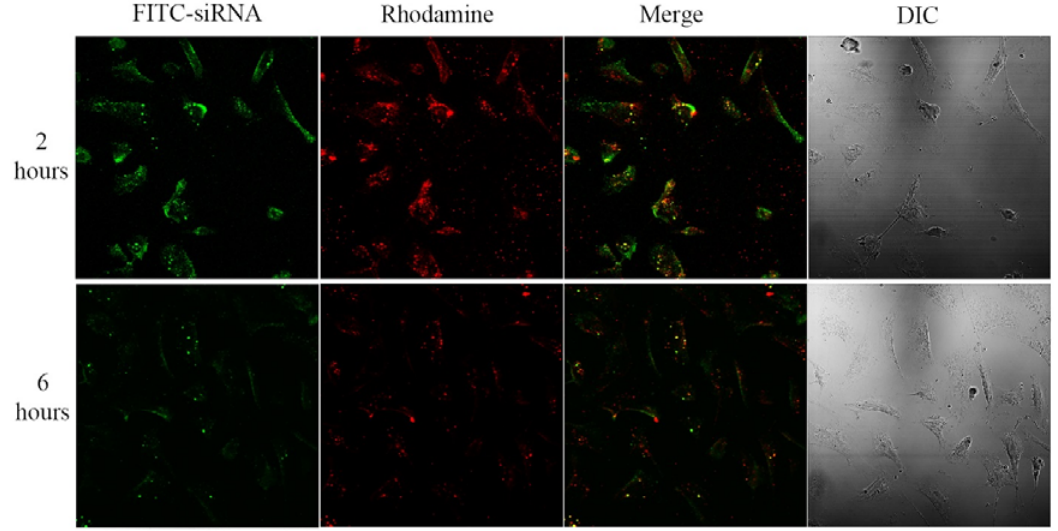
Figure 3. Representative laser confocal fluorescence microscopy fields of view of MDA ‐ MB ‐ 231 cells treated with siRNA/dextran nano ‐ carrier. Cells were treated with fluorescein isothiocyanate (FITC) ‐